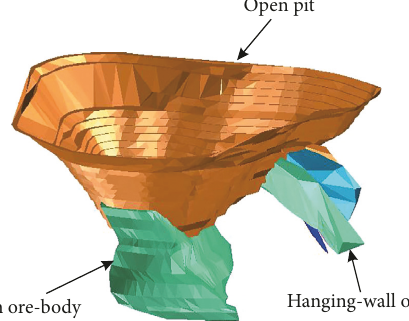
Figure 1: A mode of the occurrence of hanging-wall ore-body at the Dagushan Iron Mine in